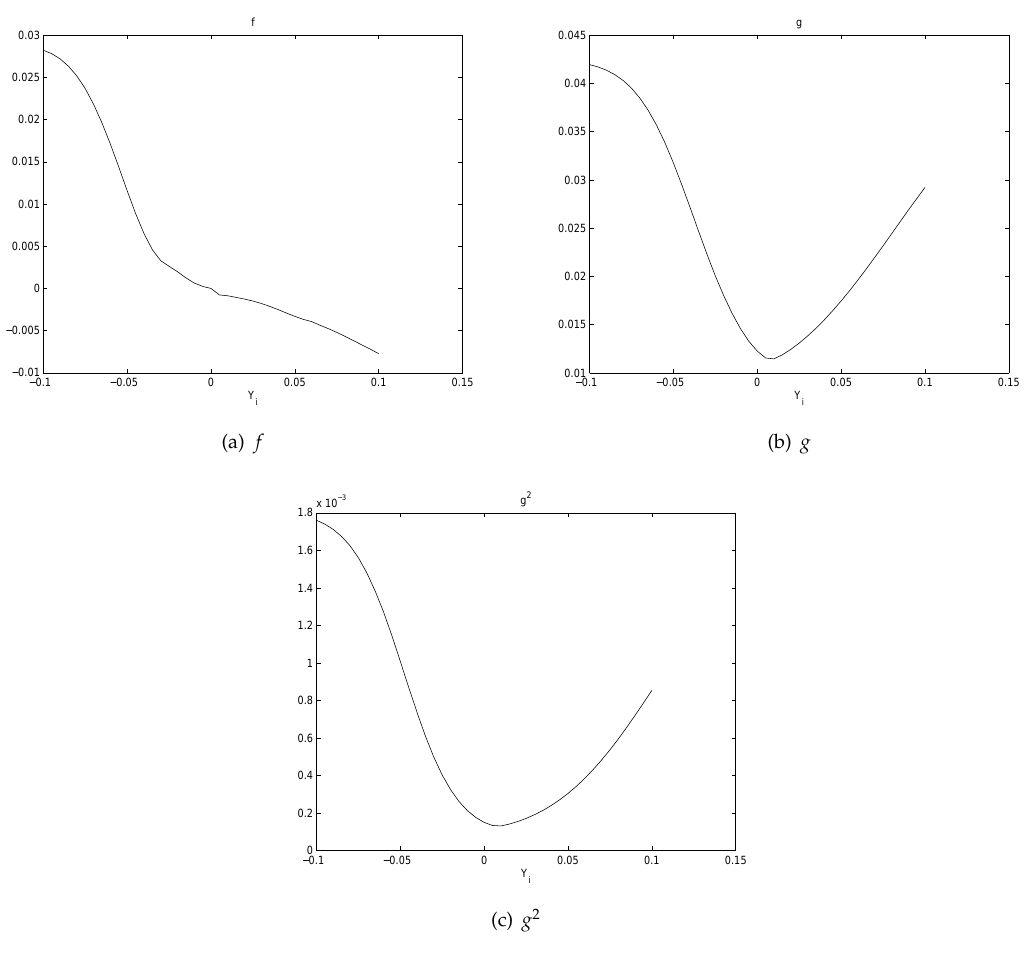
Figure 23. Drift and volatility